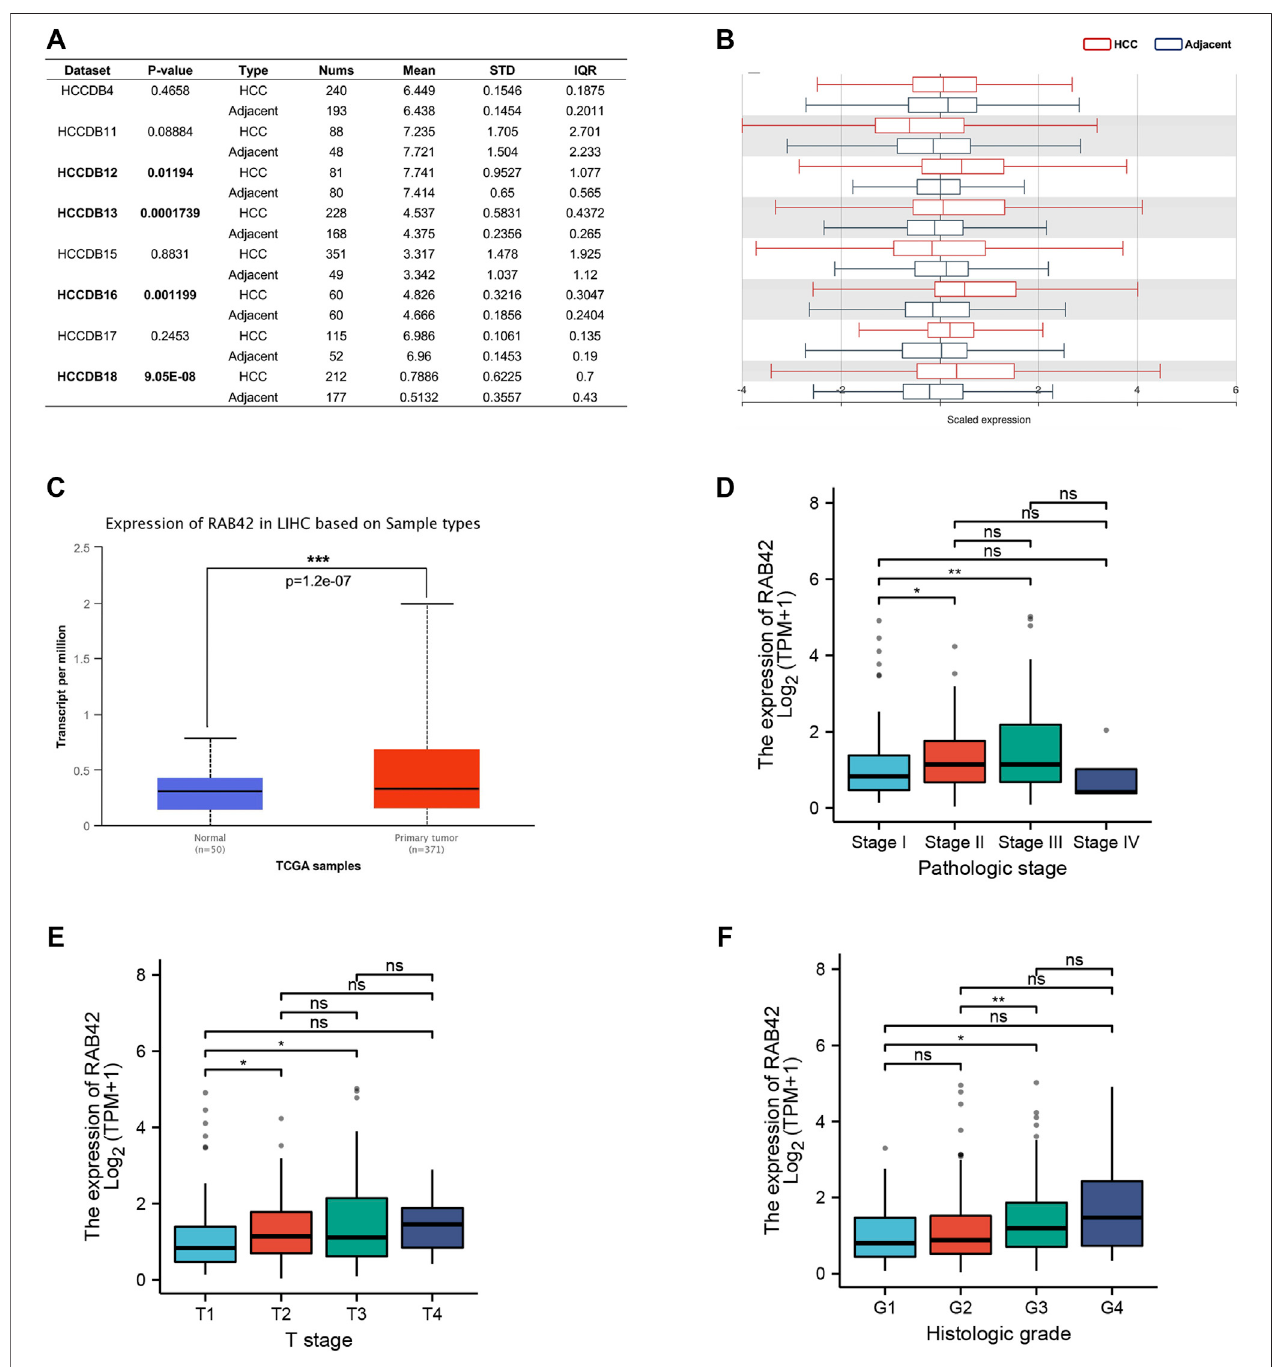
FIGURE2| TheexpressionlevelofRAB42inHCCanditsrelationshipwithindividualclinicalparameters. (A) Thetableand (B) histogramlistedeightHCCcohortsin theHCCDBdatabase,andRAB42wassigni fi cantlyhighlyexpressedcomparedtotheadjacentlivertissuesinfourofthesedatasets,namelyHCCDB12andHCCDB13, HCCDB16, HCCDB18. (C) Analysis using the UALCAN database also showed that RAB42 had higher expression in HCC compared to normal tissues. The expression of RAB42 signi fi cantly increased with advancing stage (D) , increasing T stage (E) and histologic grade. (F) * p < 0.05, ** p < 0.01, *** p < 0.001, ns, no signi fi cance; HCC, hepatocellular